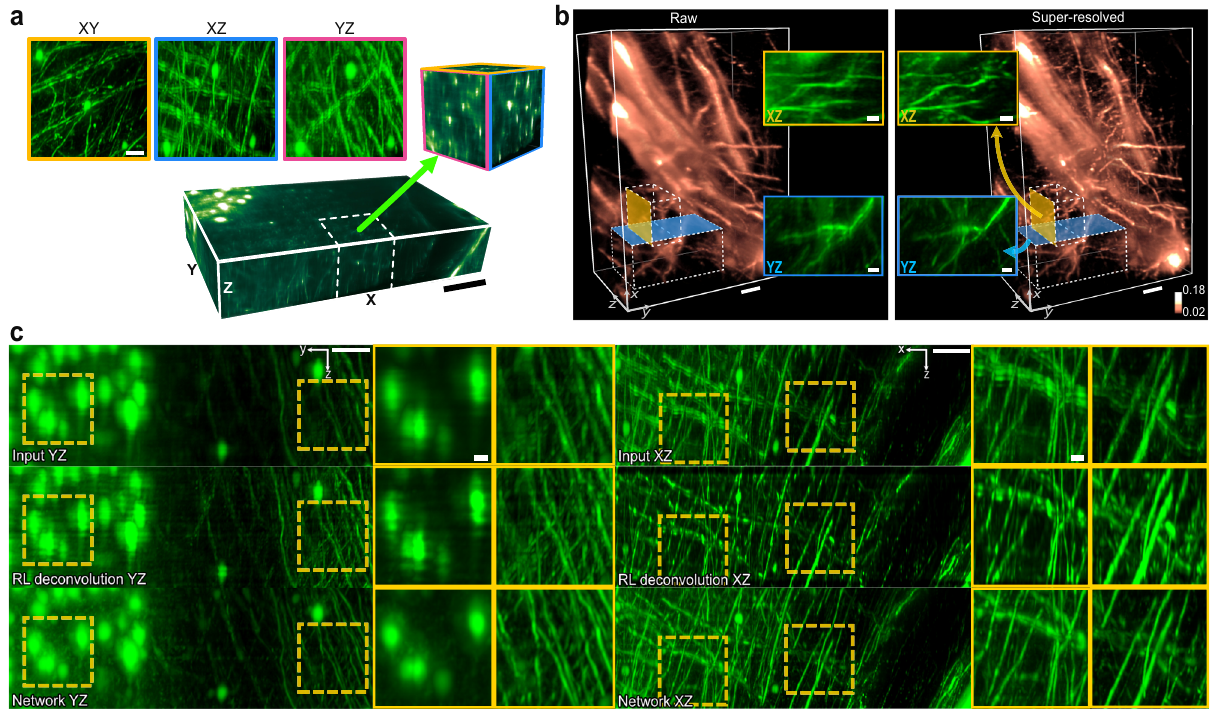
Fig. 4 Image restoration by the proposed framework in large-throughput imaging using OT-LSM. a Comparison of image qualities between the orthogonal image planes in an uncalibrated OT-LSM, using MIP images of a selected 3D ROI. Scale bar: 100 µ m and 25 µ m (zoomed-in ROIs). b 3D reconstructions of somata and basal dendrites of pyramidal neurons, with axial MIP images of selected 3D ROIs. The network corrected the doubling effect in the XZ plane and also enhanced the contrast between the signals and the background. The resolution enhancement was consistent across the XZ plane and YZ plane. The input and output images were visualized on the same intensity spectrum. The color bar represents the signal intensity normalized between 0 and 1. Scale bars: 25 µ m. c YZ and XZ MIP images from the input, the deconvolution result by the Richardson-Lucy algorithm, and the network output. Deconvolution and artifact correction in the network output was consistent throughout 8600 slice images of the OT-LSM volume. The MIP images are in depths of 150 µ m. Experiments were repeated with six independent image volumes, achieving similar results. Scale bars: 50 µ m and 10 µ m (zoomed-in axial under-sampling and illustrated in the ground-truth ROIs in Supplementary Fig. 13a. To quantify the axial resolution improvement, we divided the test volume into eight non- overlapping regions and calculated the image quality metrics on their respective MIPs with 17.5 µm depths. PSNR and MS-SSIM were used as the reference-aware metrics, and BRISQUE 39 was used as the no-reference image quality metric to assess the perceptual naturalness of the output image, in comparison to the input and the ground truth. We noticed improvements in all the metrics (Supplementary Fig. 13b). The BRISQUE metric suggests that the output images were perceptually more natural than the blurred input, with little difference from the ground truth. We also noticed an overall PSNR improvement of 1.98 dB in the 3D output volume.